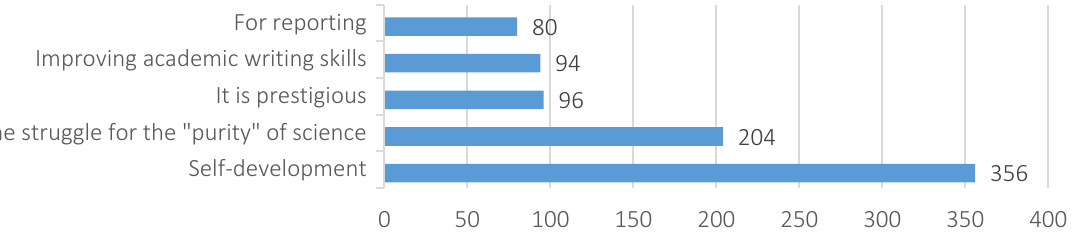
Figure 3. Distribution of answers to the question “What is your main motivation to be a